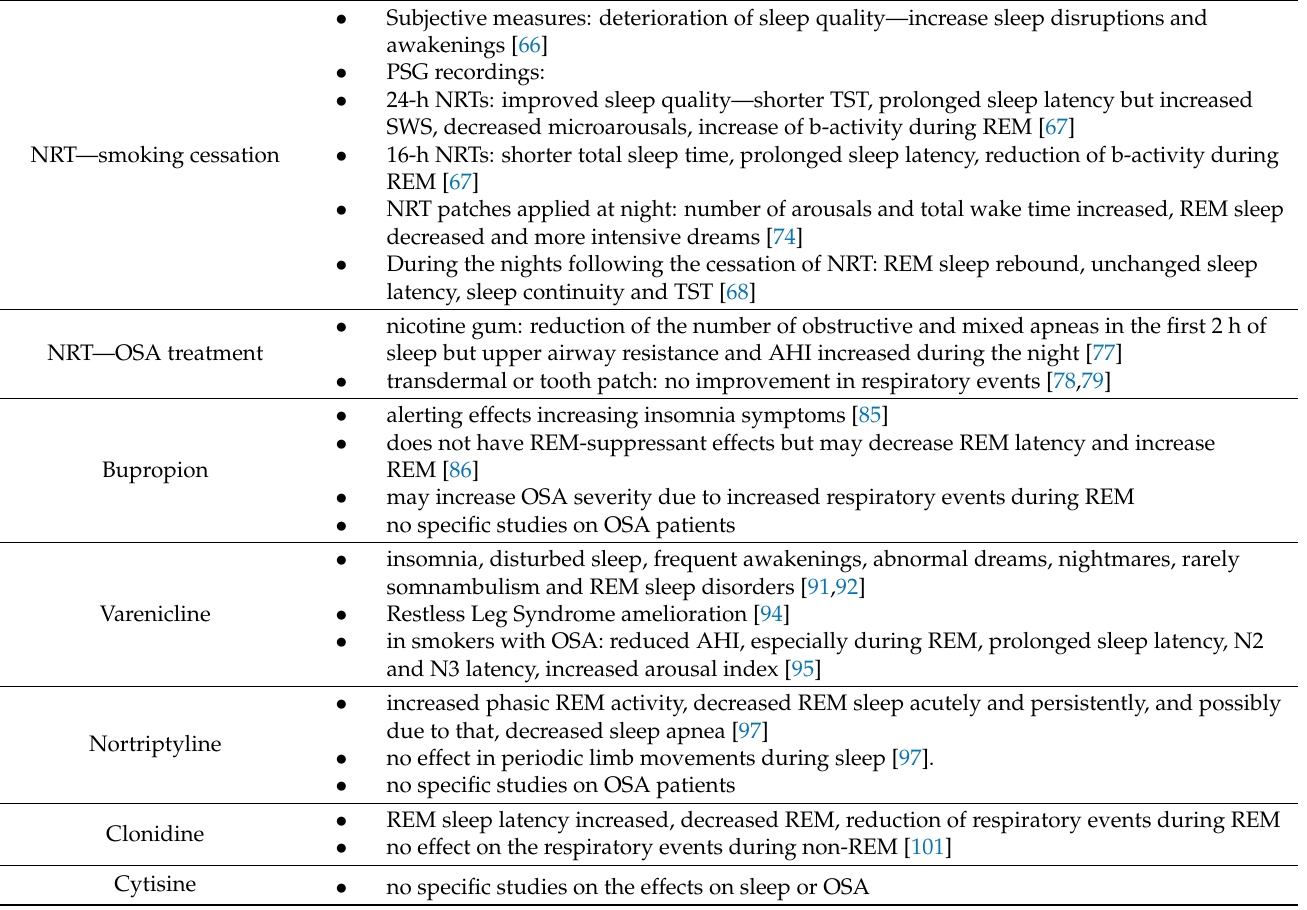
Table 1. Summary of the effects of medications used for smoking cessation on sleep and